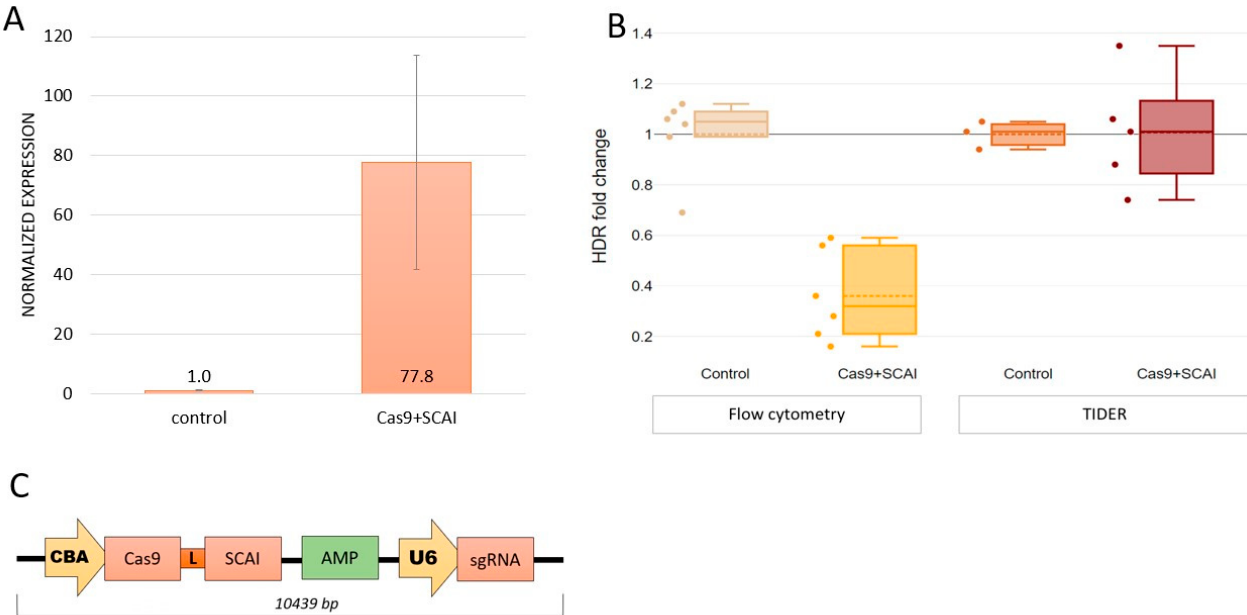
Figure 3. Cas9-SCAI fusion does not increase HDR efficiency (dashed line represents mean, solid line—median, whiskers—95% CI). ( A )—SCAI expression in HEK293T-eGFPmut cells transfected with Cas9-SCAI-sgRNA/ssODN is 77 times higher than in cells transfected with Cas9-sgRNA/ssODN (Control). ( B )—Using the genome editing method with spCas9-SCAI fusion protein does not increase the number of GFP-positive cells or corrected alleles compared to regular spCas9 (control samples). ( C )—Scheme of the plasmid with Cas9-SCAI. CBA—chicken β -actin promoter, L—SGSETPGTSESATPES linker, AMP—ampicillin resistance gene, U6—U6 promoter, and